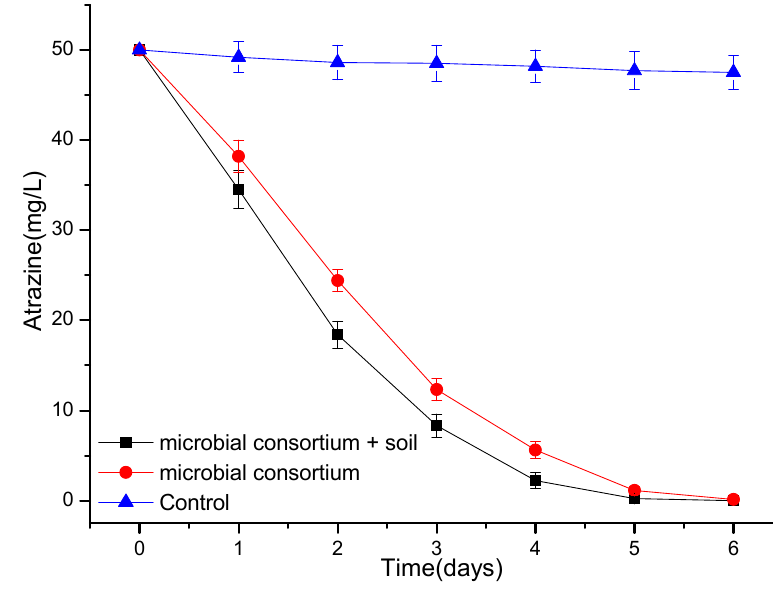
Figure 8. The curve of the degradation of atrazine by a microbial consortium and natural soil.